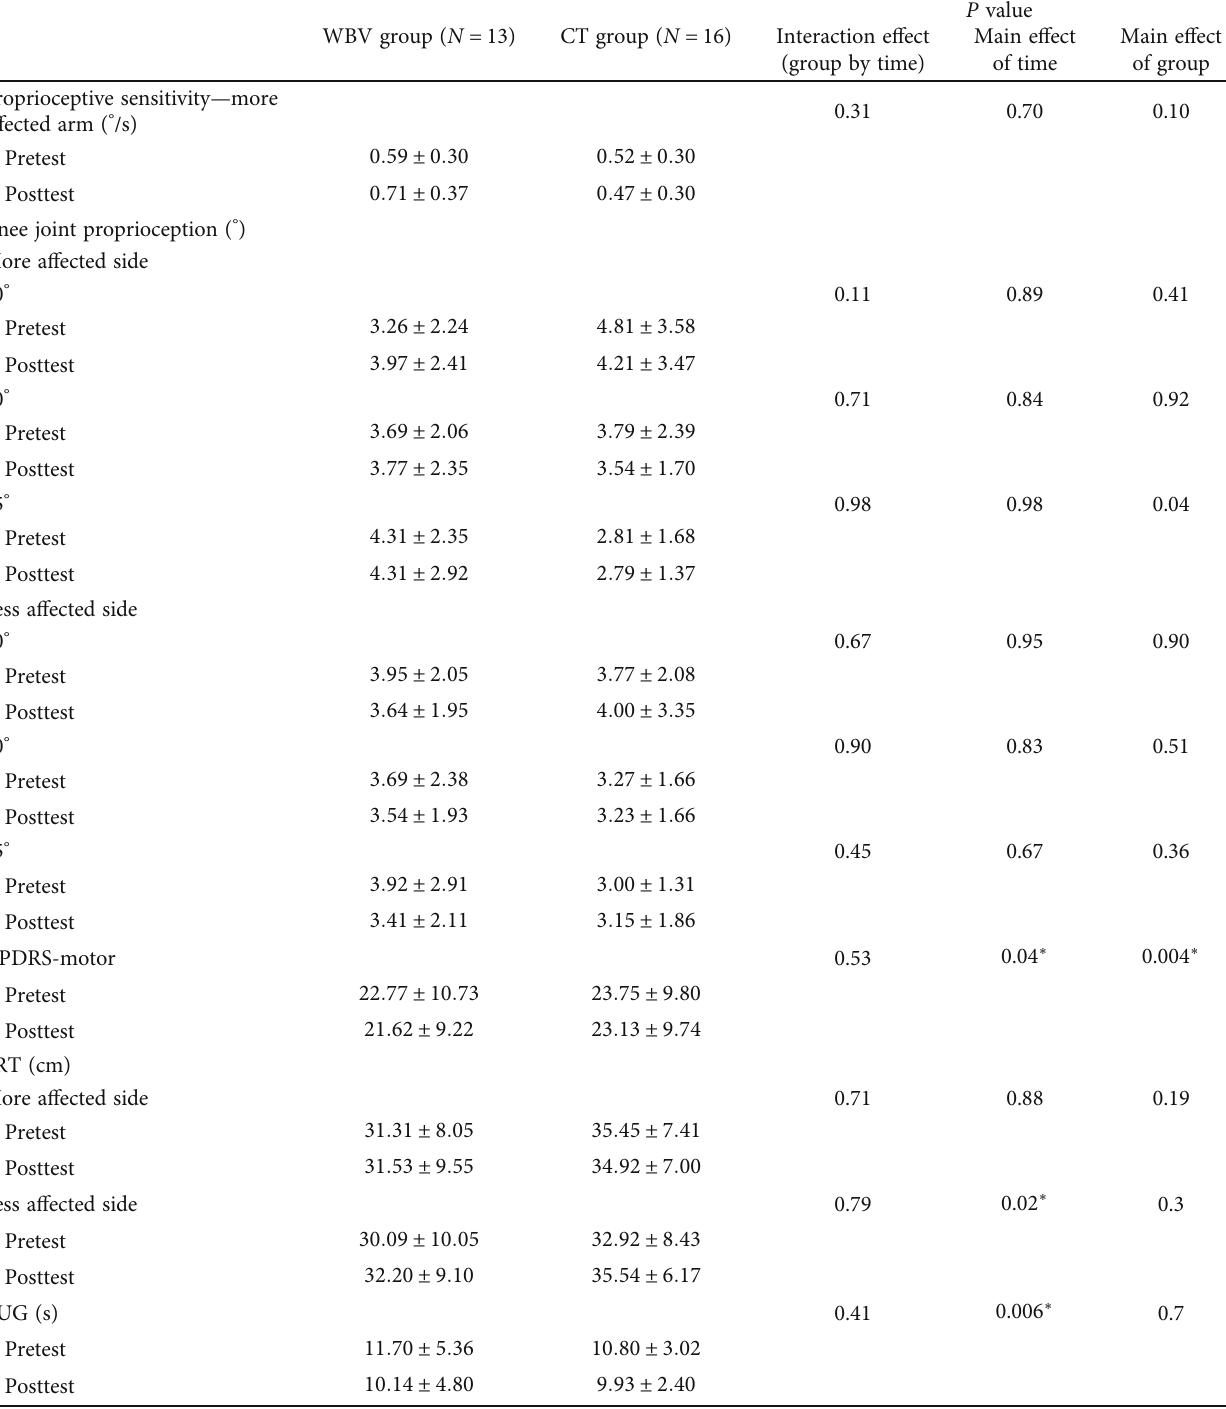
Table 2: Means and standard deviations for the outcome measures before and after